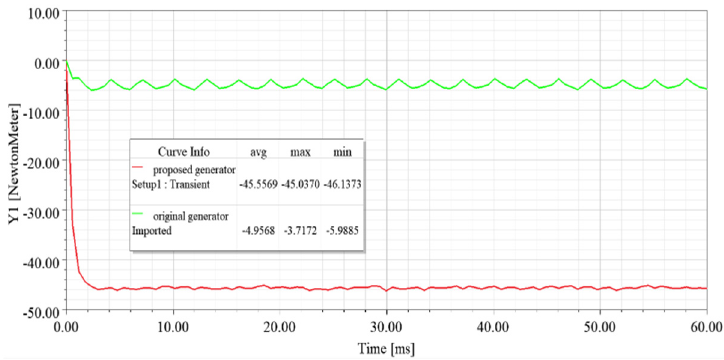
Figure 18. Moving torque of original generator and proposed